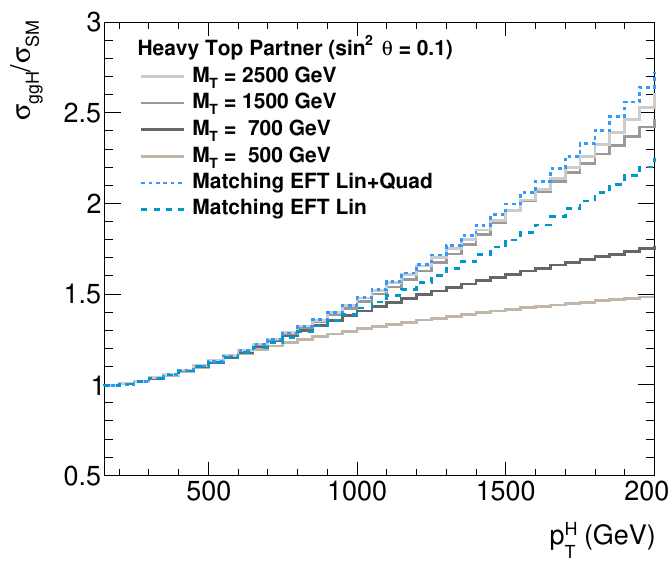
p H spectra normalised to the SM prediction for the heavy top partner model with T M T = 500, 700, 1500, 2500 GeV and sin 2 θ = 0.1. The SMEFT spectra for the matched Wilson coefficients and only linear (dashed) and linear plus quadratic (dotted line) terms are also